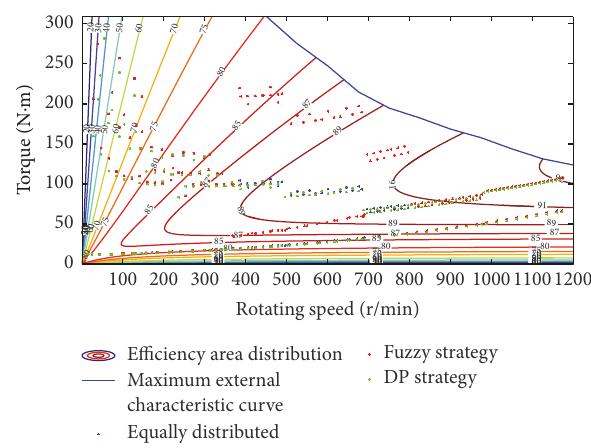
Figure 20: The comparison of the efficiency distribution of the motor.